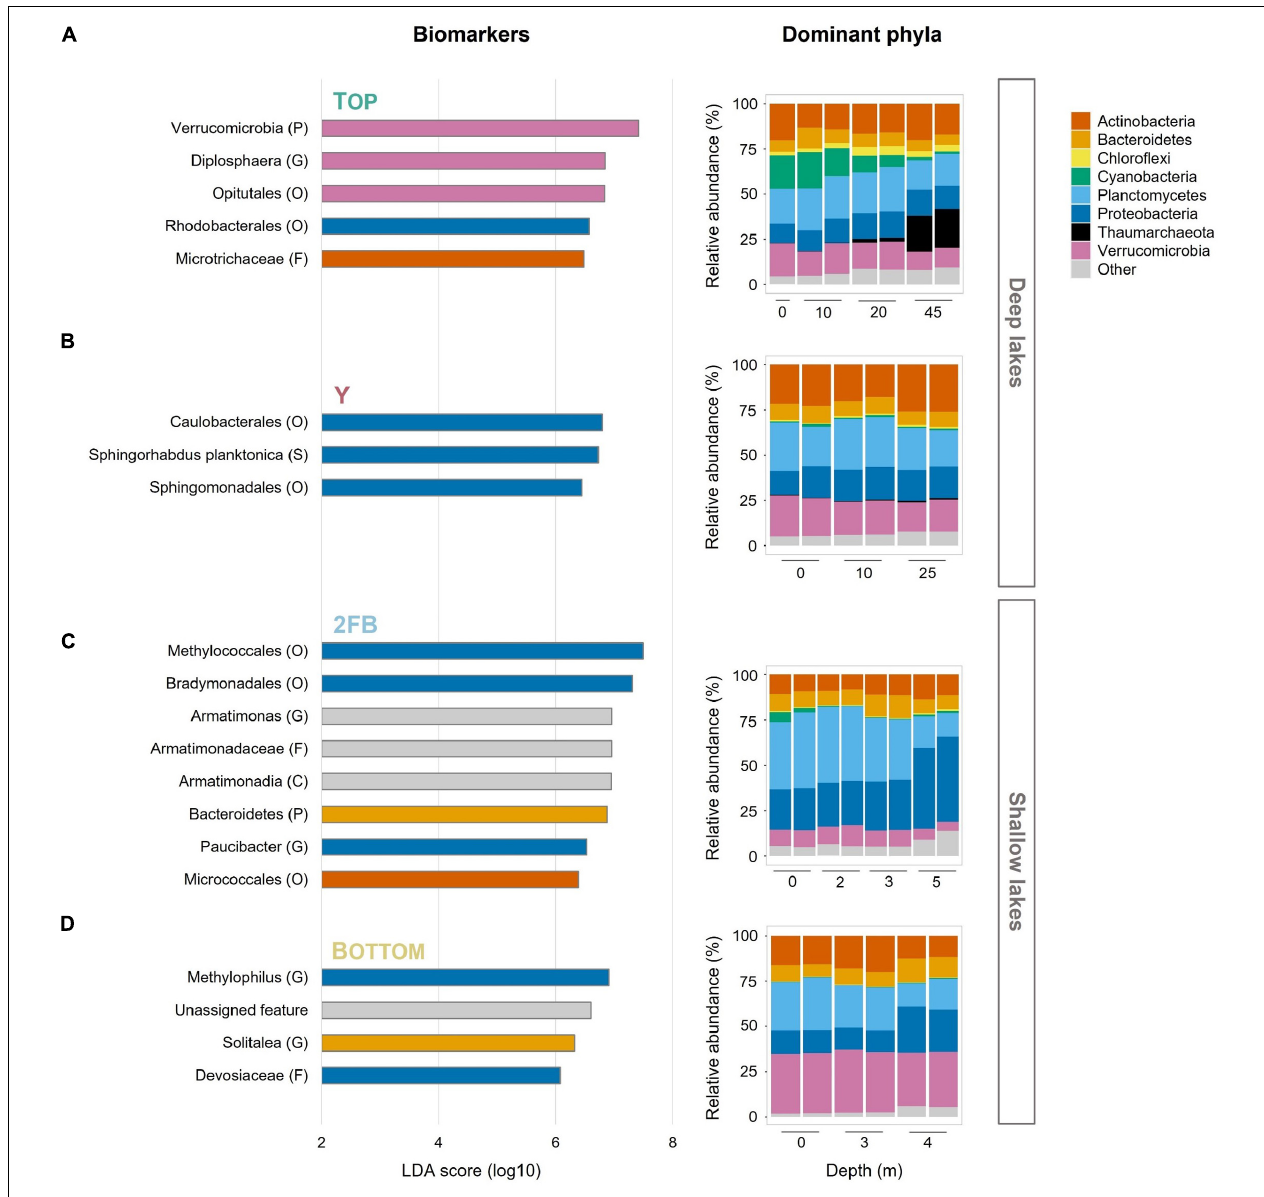
FIGURE 3 | Features and relative abundances of major phyla in the four Stuckberry Valley lakes. (A) Top Lake, (B) Y Lake, (C) 2FB Lake, and (D) Bottom Lake. The linear discriminant analysis (LDA) score (log 10) was used to estimate the size effect of each biomarker. The letters in parentheses correspond to the taxonomic rank (P, phyla; C, class; O, order; F, family; G, genus; S, species) and colors correspond to phyla. The color of the lake name is consistent with the map in Figure 1 . In Bottom Lake, the unassigned feature represents an ASV without any taxonomic assignment. In the relative abundance graphs, phyla that represent less than 5% of reads in at least one sample were grouped together as “Other.” Note that each sample had two replicates (except 0 m in Top